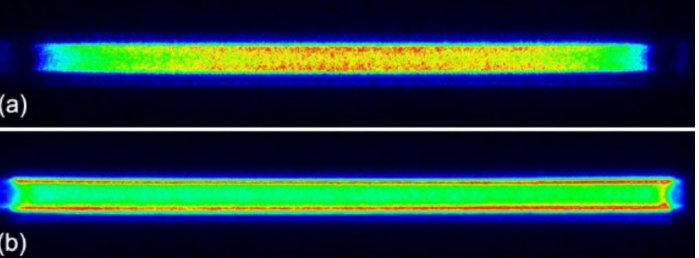
Figure 3. ICCD photos: ( a ) and ( b ) correspond to point 1 and point 12 in Figure 2 (exposure time: 100 µ